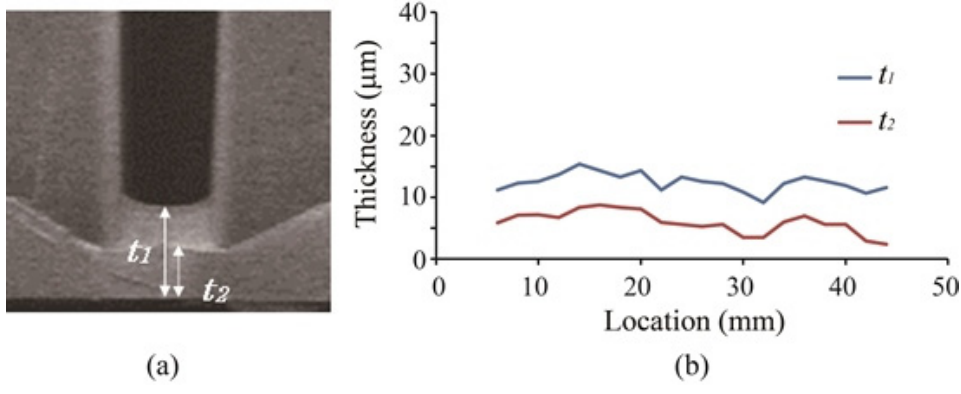
Figure 9. ( a ) Definitions of two types of residual layer thicknesses (RLTs) and ( b ) RLTs within the roll-pressed